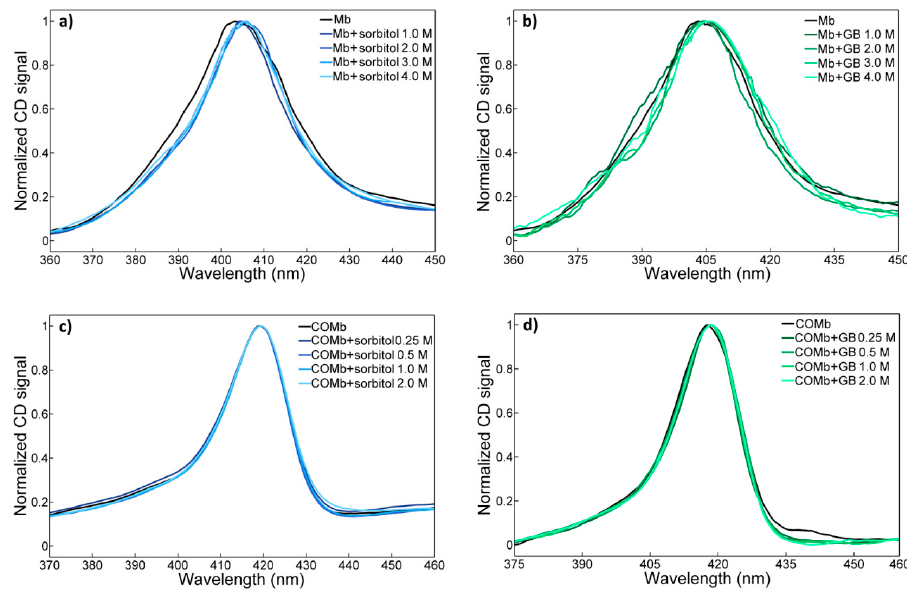
Figure 5. Concentration-dependent CD spectra (Soret band) of ( a ) metmyoglobin in sorbitol solutions, ( b ) metmyoglobin in glycine betaine solutions, ( c ) carbonmonoxy-myoglobin in sorbitol solutions and ( d ) carbonmonoxy-myoglobin in glycine betaine solutions.